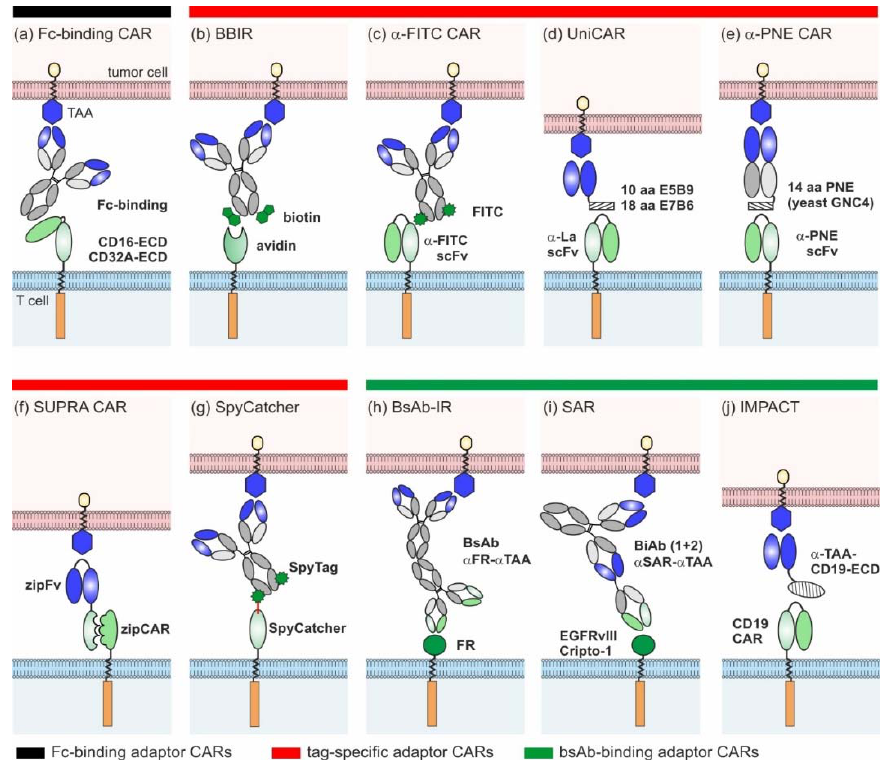
Figure 2. Overview of di ff erent adaptor CAR designs: ( a ) Fc-binding CAR, ( b ) biotin-binding immune receptors (BBIRs), ( c ) α -FITC CARs, ( d ) UniCARs, ( e ) α -peptide-neoepitope (PNE) CARs, ( f ) split, universal, and programmable (SUPRA) CARs, ( g ) SpyCatcher, ( h ) bispecific antibody-binding immune receptors (BsAb-IRs), ( i ) synthetic agonistic receptors (SARs), and ( j ) Integrated Modules oPtimize Adoptive Cell Therapy